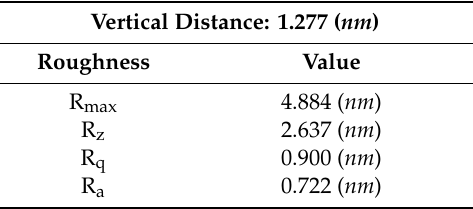
Figure 8. AFM inspection for NDG. ( a ) 2D image for NDG powder. ( b ) 3D morphology for NDG powder. ( c ) Roughness measurement for NDG powder. Table 2. Roughness measurement